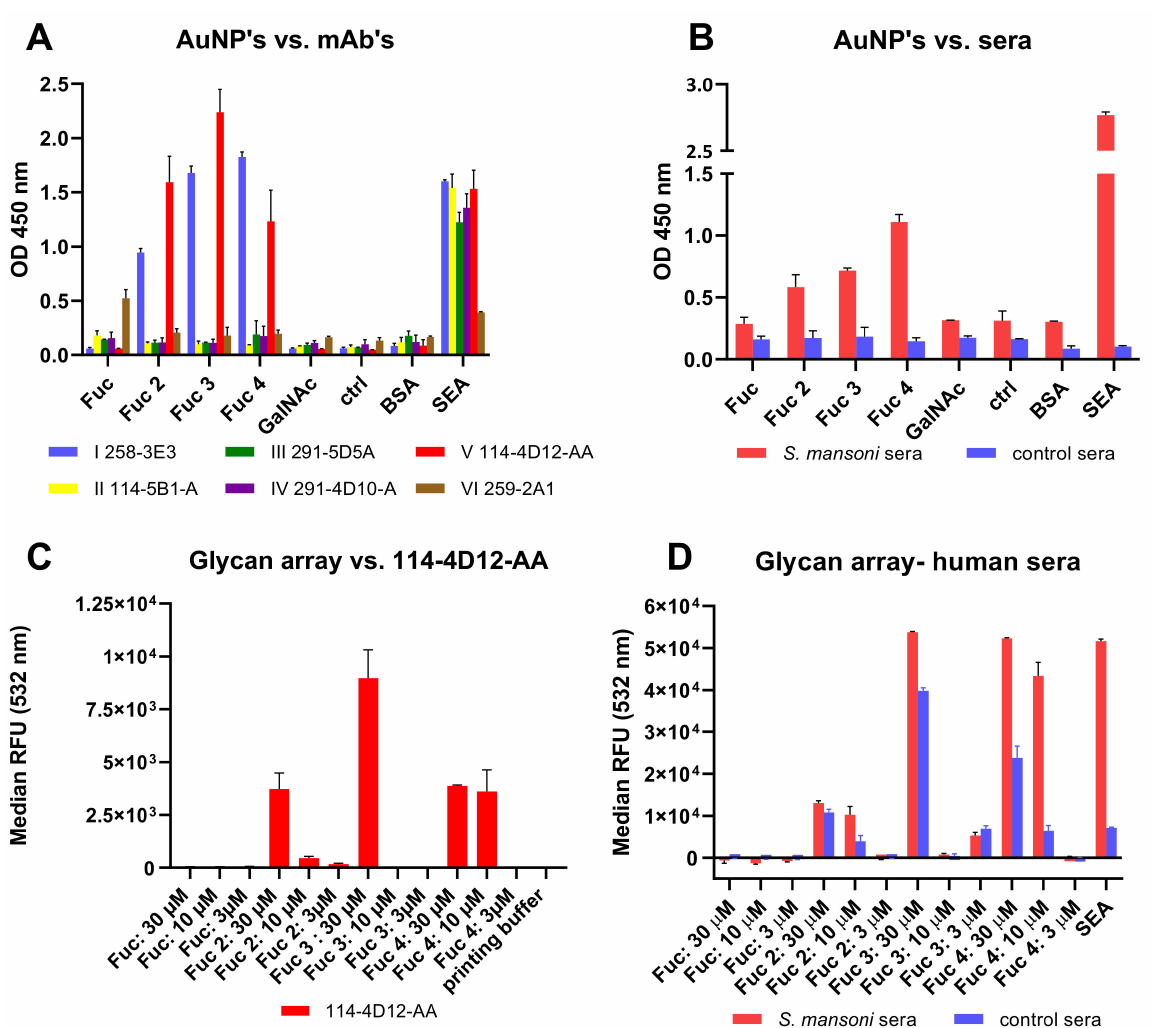
Figure 2. Evaluation of antibody binding to the generated oligofucosides. Bar graph of the results of the ELISA experiment with IgG monoclonal antibodies ( A ) and pooled human sera ( B ) from either infected (red) or control samples (blue). Bar graph of glycan array experiment with mAb 114-4D12-AA ( C ) and with pooled human sera from either infected (red) or control samples (blue) ( D ). AuNP: gold nanoparticle, Fuc x : α -(1-2) linked fucosyl chain, where x denotes the number of fucoses, GalNAc: 6-aminohexan-1-ol N-acetyl- β - D -galactosamine, ctrl: unfunctionalized AuNP, BSA: bovine serum albumin, SEA: soluble egg antigen, OD: optical density, RFU: relative fluorescence units. Error bars indicate standard deviations of the experiment performed in duplicate (ELISA) or triplicate (glycan array)